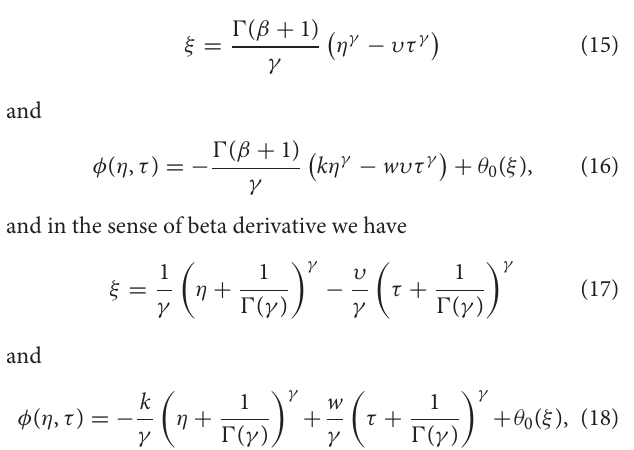
0.5, β 0.9 for (27). (B) Beta with γ = =